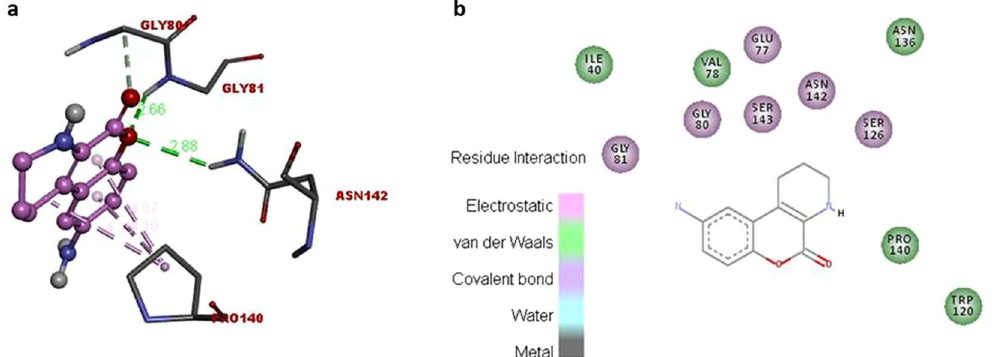
Figure 8. In silico molecular docking analysis of partially purified BFE against growth and pathogenicity related transcriptional cofactor FG. ( a ) 3D structure of interactions between pathogenicity related transcriptional cofactor FgSWi6 and partially purified compound H-[1]Benzopyrano[3,4-b]pyridin-5-one, 9-amino-1,2,3,4- tetrahydro-, ( b ) 2D structure of binding site of cofactor FgSWi6 and H-[1]Benzopyrano[3,4-b]pyridin-5-one,